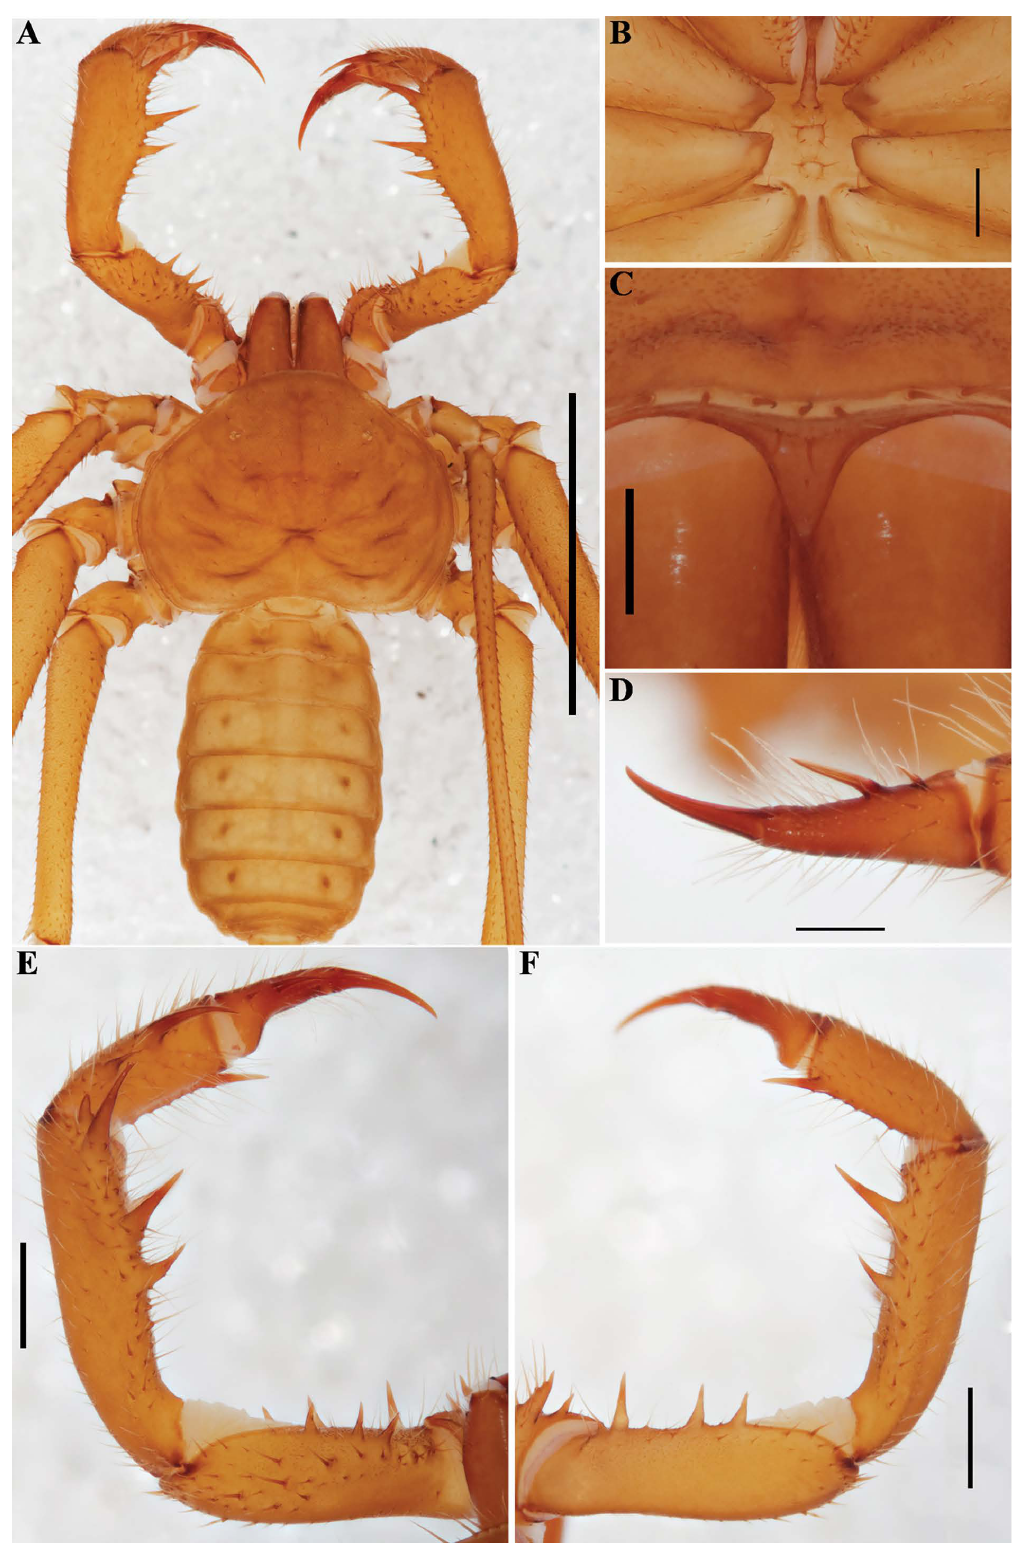
Fig. 69. Charinus monasticus sp. nov. (MNRJ 9103), general morphology. A . Habitus, dorsal view. B . Sternum, ventral view. C . Frontal process. D . Pedipalp tarsus, frontal view. E . Pedipalp, dorsal view. F . Pedipalp, ventral view. Scale bars: A = 0.5 cm; B, E–F = 1 mm; C–D =